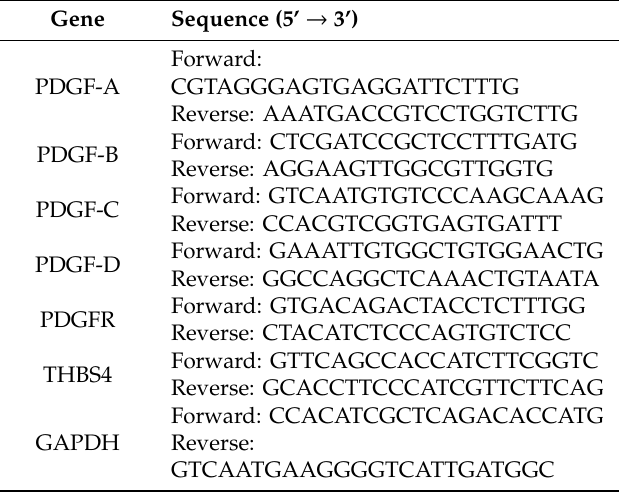
Table 2. The sequence of primers.